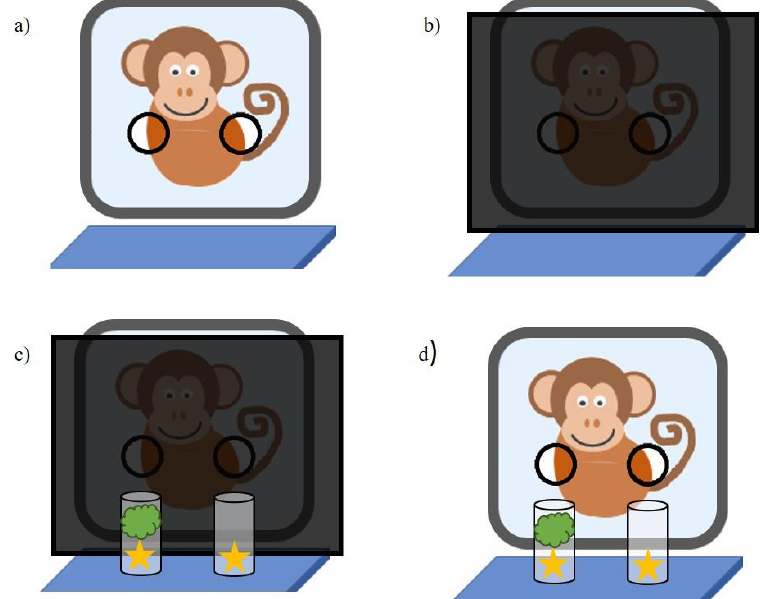
An Illustration of the Procedure for Presenting Monkeys with the Cups in Experiment 3